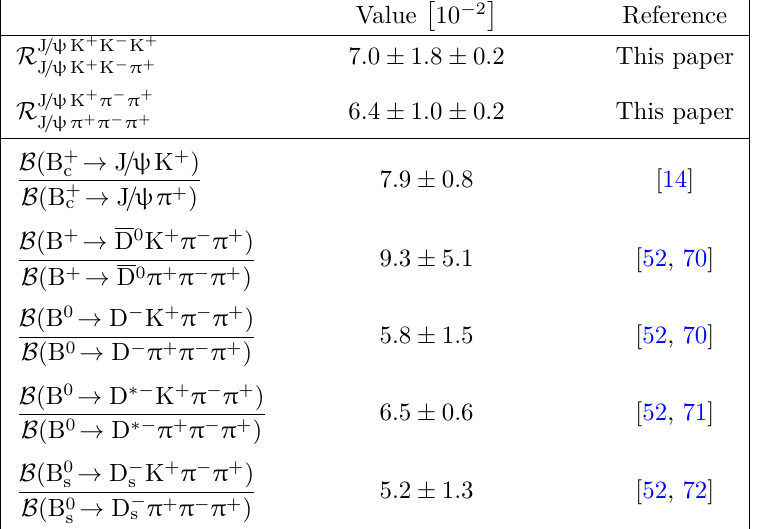
Table 6 . Comparison of the measured ratios of branching fractions for the Cabibbo-suppressed and Cabibbo-favoured decays with the ratios of branching fraction for similar decays of B + B 0 and B 0 mesons [14, 52, s